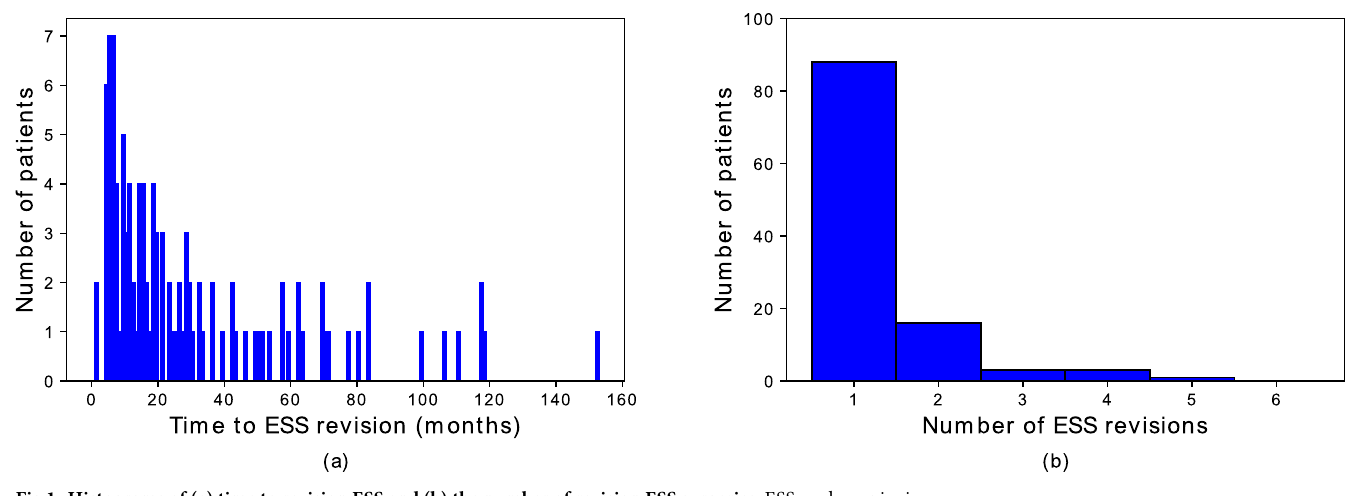
Fig 1. Histograms of (a) time to revision ESS and (b) the number of revision ESS surgeries. ESS, endoscopic sinus surgery.